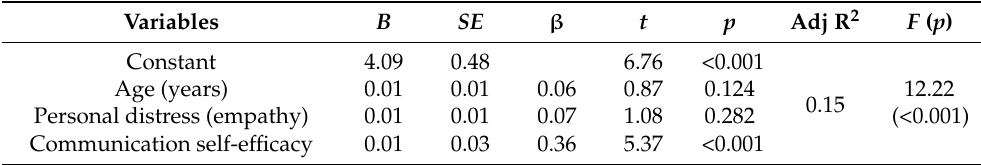
Table 4. Multiple Regression for Patient-Centered Sharing (Patient–Practitioner Orientation Subscale) ( n = 201).